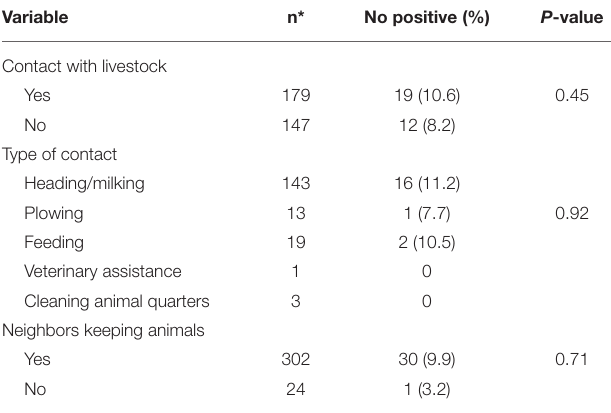
TABLE 4 | Relationship between Cryptosporidium infection in HIV positive individuals and contact with livestock among family members in Namwala district, Zambia ( n =